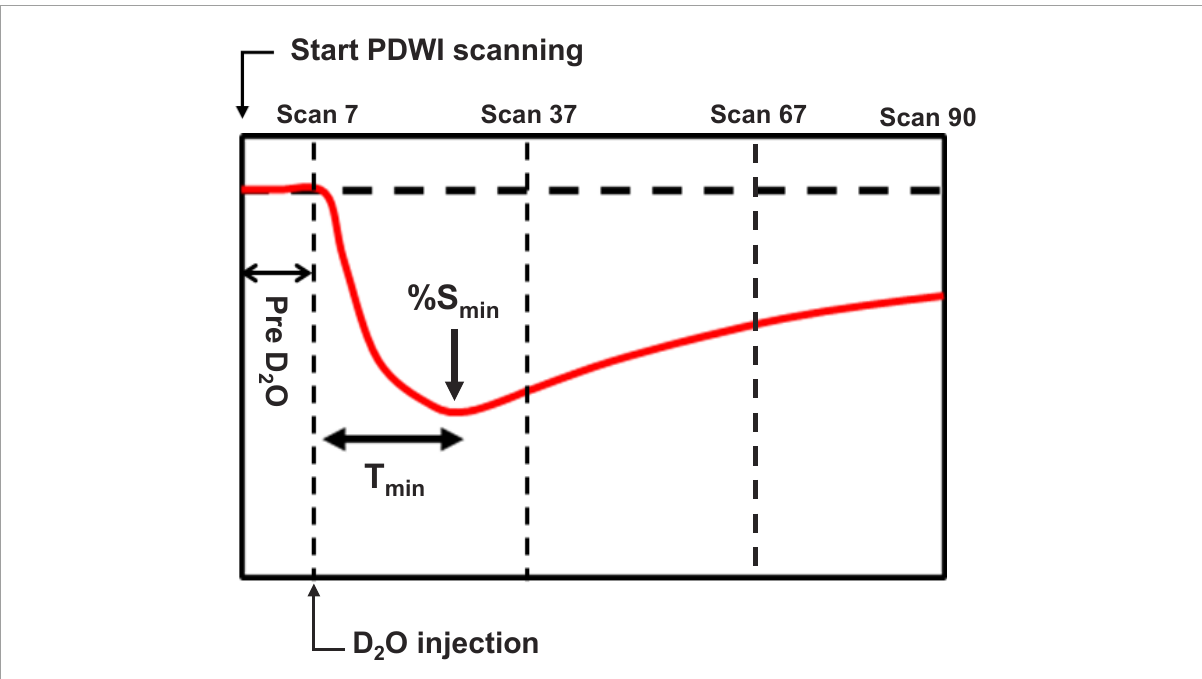
FIGURE1 Schematic defining the timing of deuterium-labeled water (D 2 O) administration in comparison to the proton-density-weighted imaging (PDWI). PDWI images were acquired every 20 s for 30 min (90 scans total). Two min after scanning started, D 2 O was administered intraperitoneally. T min indicates the time from administration to the signal